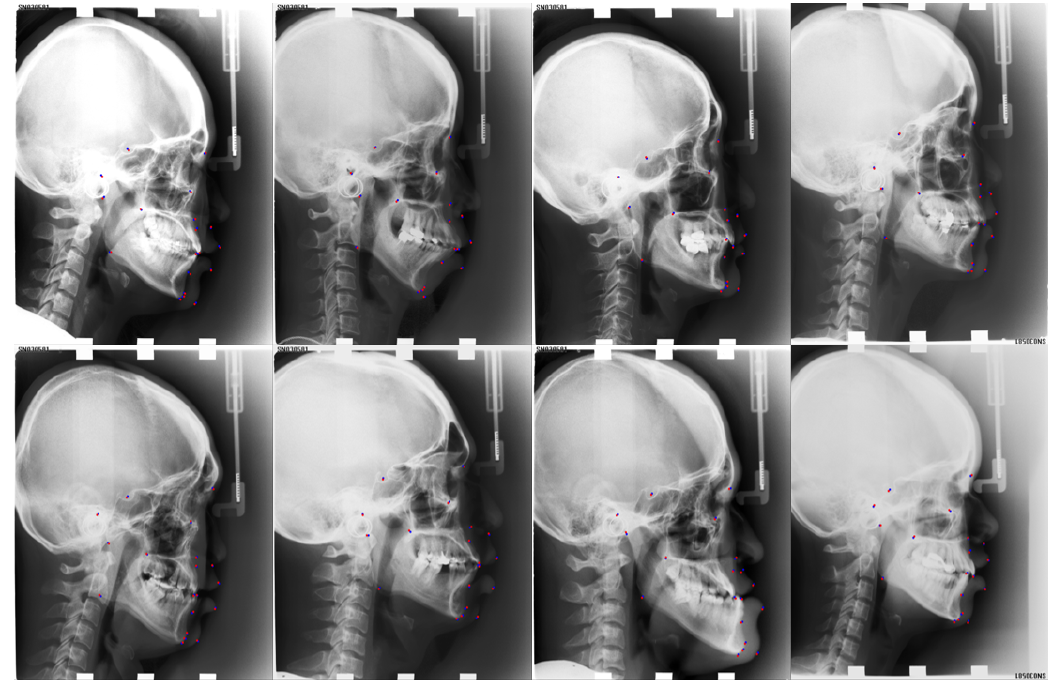
Figure 9. Visualized results of our approach for the ISBI2015 dataset. Red points are predicted landmarks; blue points are ground